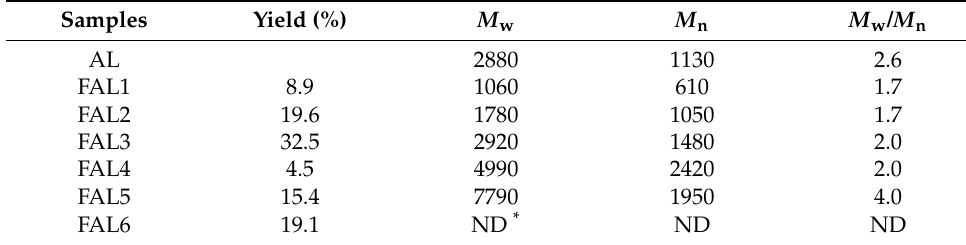
Table 2. The yields of alkaline soda lignin fractions and their GPC information. Samples Yield (%)